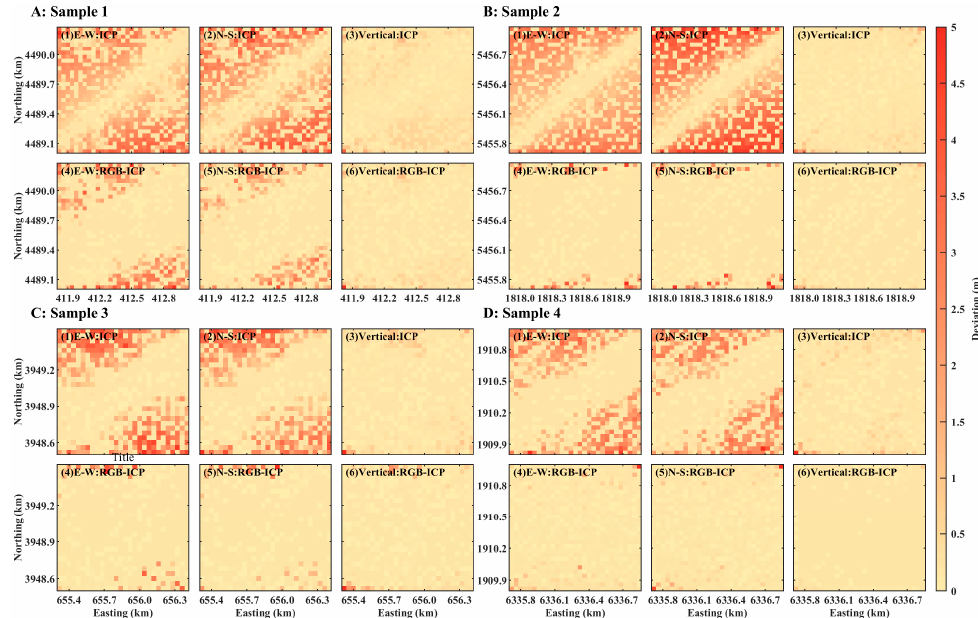
Figure 7. Distribution of absolute deviation of 3D deformation obtained by applying the two algorithms (smooth terrain): ( A – D ) correspond to four groups of sample data, and each sample includes the deviation results of the ICP algorithm (( 1 )–( 3 )) and the RGB-ICP algorithm (( 4 )–( 6 )), where ( 1 ) and ( 4 ) are in the E-W direction; ( 2 ) and ( 5 ) are in the N-S direction; and ( 3 ) and ( 6 ) are in the vertical direction.